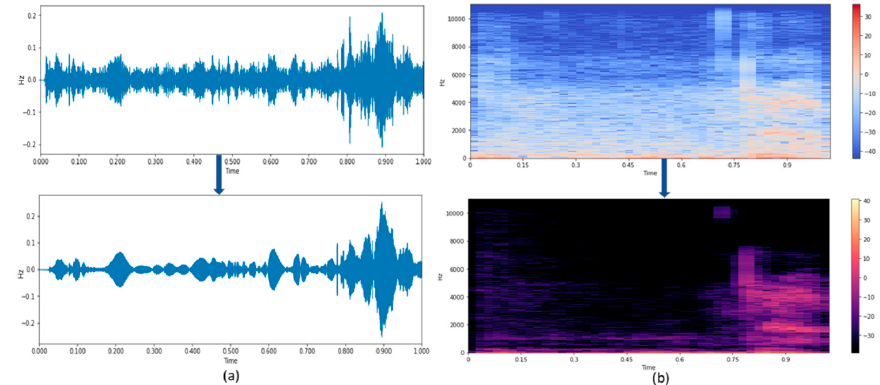
Figure 9. ( a , b ) Time waveform and Spectrogram of speech signal using NSS. The enhanced speech signal is converted into text using the HMM or the DTW-based text conversion algorithm to find the accuracy level of the enhanced speech signal. Table 4 represents the WER calculated for the enhanced speech signal using the NSS. Table 4. WER and its percentage using NSS.